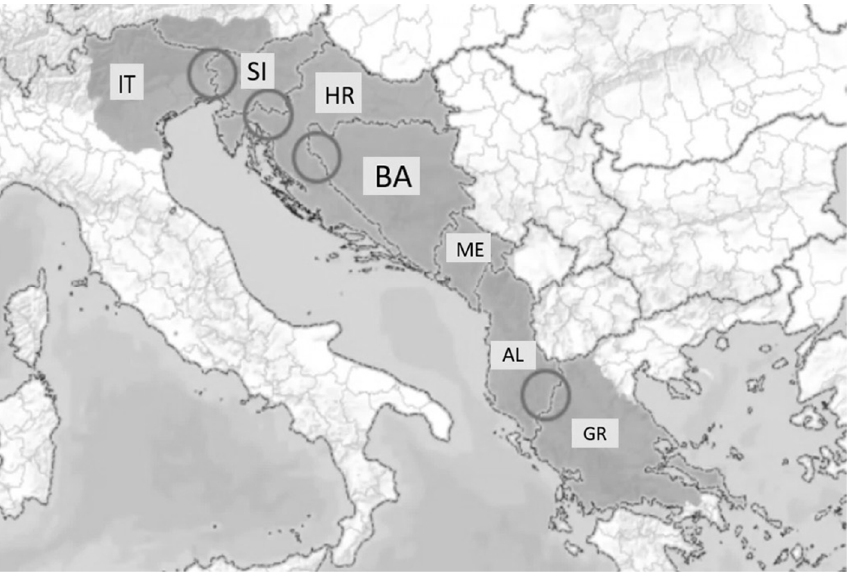
Figure 1. Countries of the Adriatic-Ionian region where ecological connectivity (EC) will be explored and consolidated. The four circles represent pilot regions selected as linkages between Natura 2000 sites and protected areas by the “Interreg Adrion DINALPCONNECT” project team. Abbreviated names of associated countries: IT; Italy, SI; Slovenia, HR; Croatia, BA; Bosnia and Herzegovina, ME; Montenegro, AL; Albania, GR; Greece.